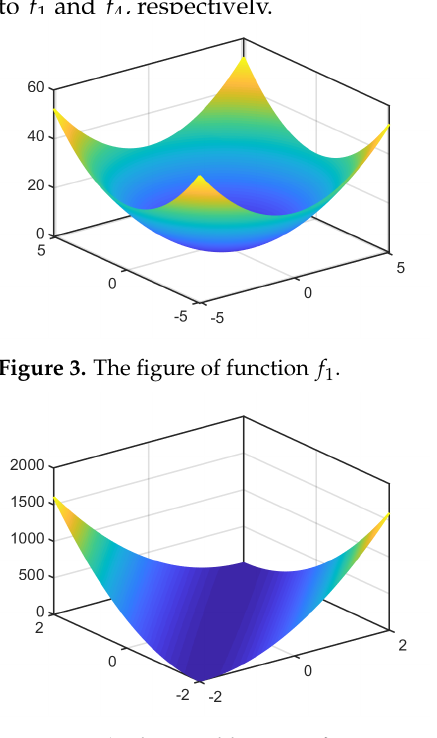
Figure 4. The figure of function f 2 .